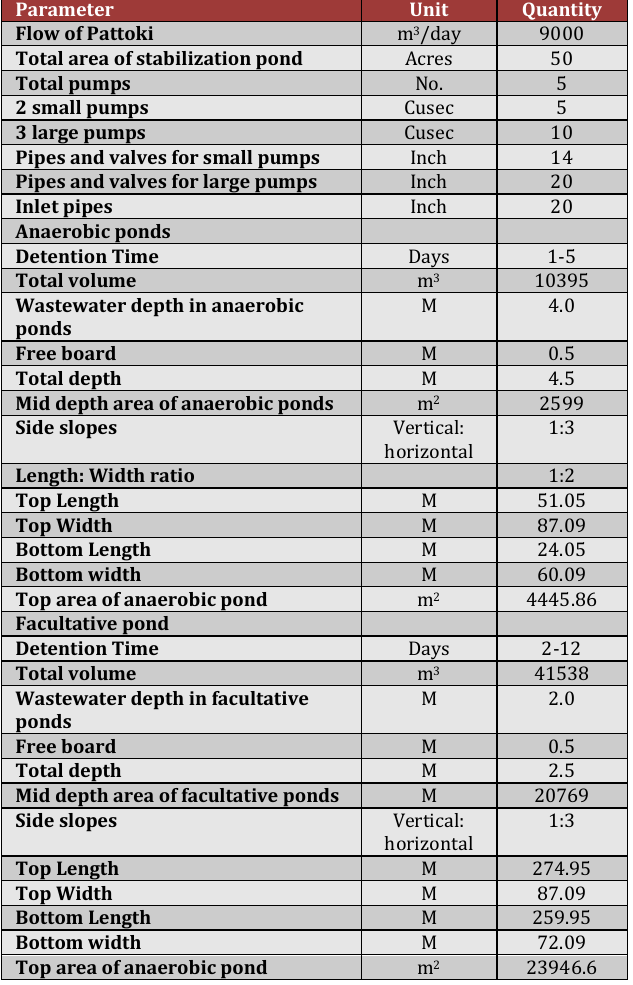
Table 1: Design parameters of WWTP Pattoki.